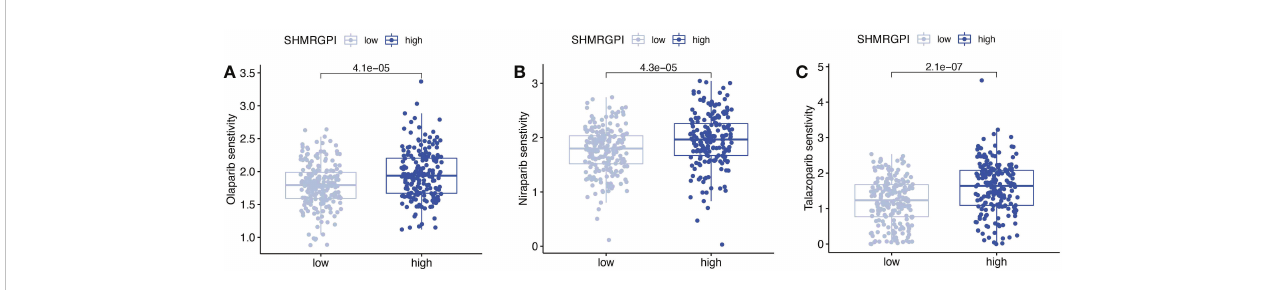
FIGURE 8 Drug sensitivity analysis. Comparison of drug sensitivity differences between SHMRGPI groups in olaparib (A) , niraparib (B) , and talazoparib (C)